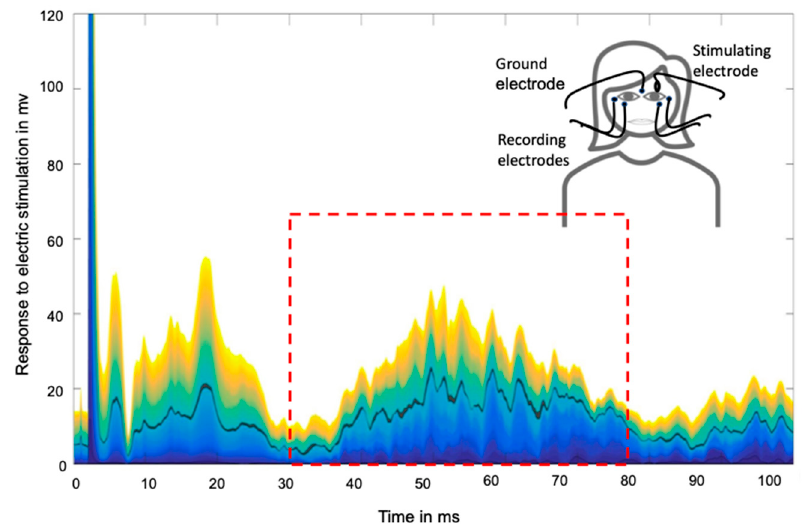
Figure 4. Three superimposed 20 nBR traces (represented by different colors) of one participant and schematic demonstration of methodological setting. Black line: calculated mean of the 20 nBR traces with an interstimulus interval of 3–5 s. The dotted red box indicates the time window of the R2 component.